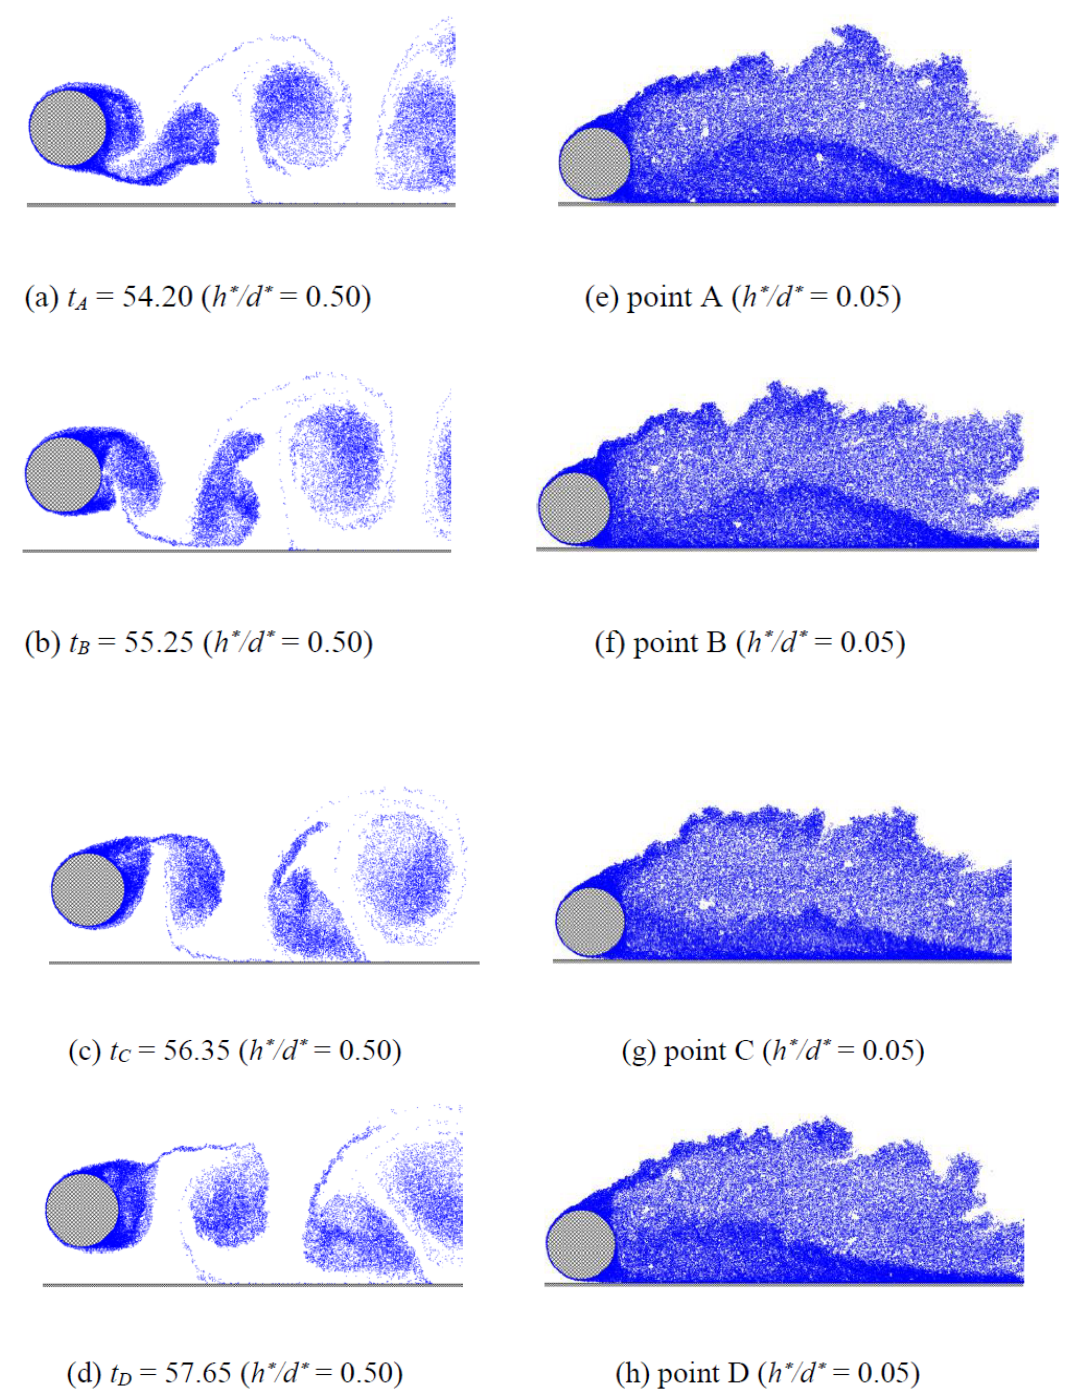
Figure 10. Near wake patterns for the slightly rough circular cylinder in the vicinity of a moving wall ( ε * / d * = 0.001; Re = 1.0 × 10 5 ).